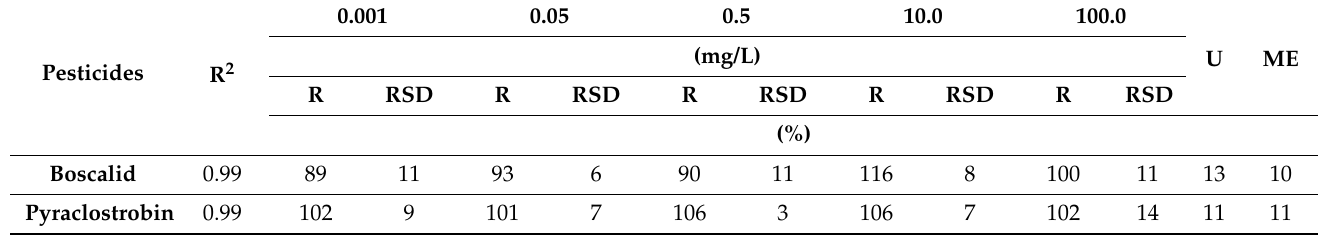
Table 5. Validation parameters of the method.